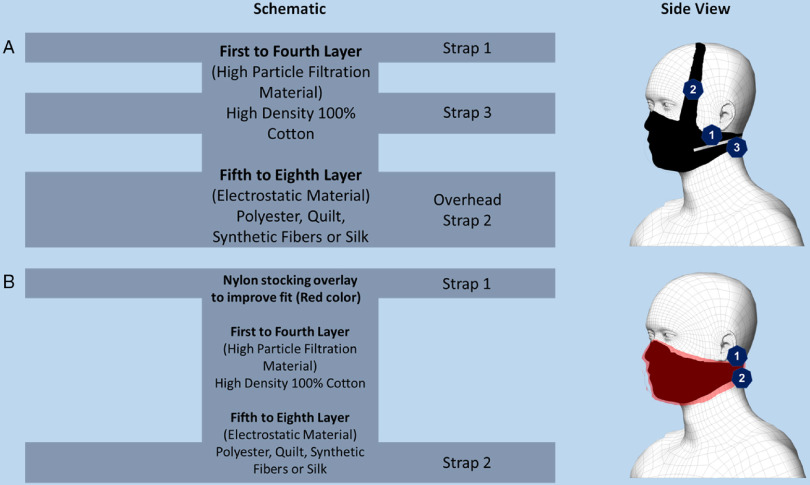
Schematics and Side View of Mask A (with overhead strap) and Mask B (with nylon overlay) Based on the Previous Findings.Both the overhead strap and nylon overlap aim to improve fit. Straps are numbered based on the order of tie.